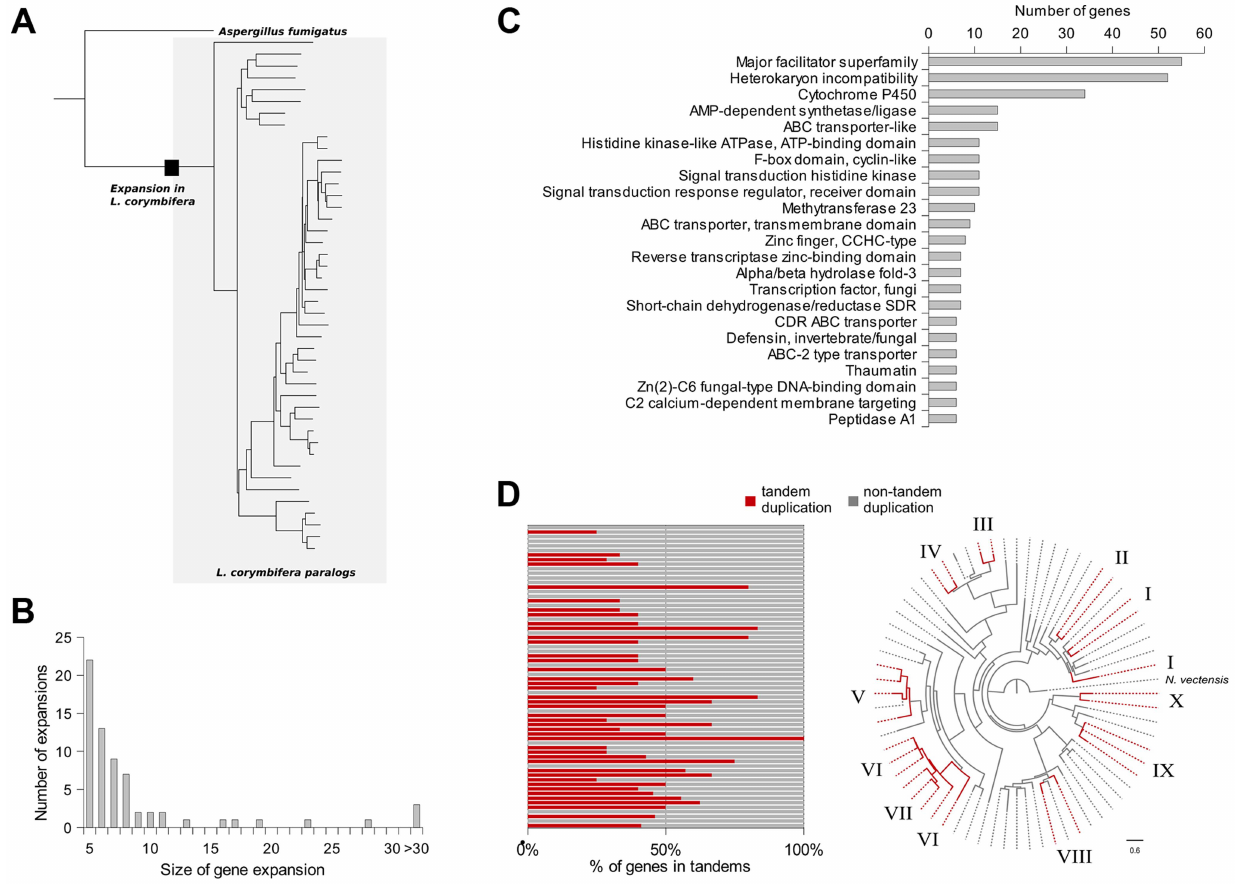
Figure 4. Gene expansions and tandem duplications found in L.corymbifera . (A) Tree representing an expansion of HET proteins in L. corymbifera . Branches enclosed in the grey shaded area represent paralogs of L. corymbifera . The black square represents the point where the expansion started. (B) Number and size of gene expansions in the L. corymbifera genome. (C) Main functional domains of gene expansions based on PFAM annotation. The numbers of genes with the different functional domains were combined if a domain was present in more than one expansion. (D) Proportion of genes within gene expansions which are arranged in tandem duplications. Each bar represents an expansion with the red part as the percentage of tandem duplicated genes (left). Clustering of tandem duplicated genes of cytochrome P450 genes in L. corymbifera (based on reconstruction with RaxML [130]). Red branches represent tandem duplicated genes. Numbers at the branch tips indicate different tandems.